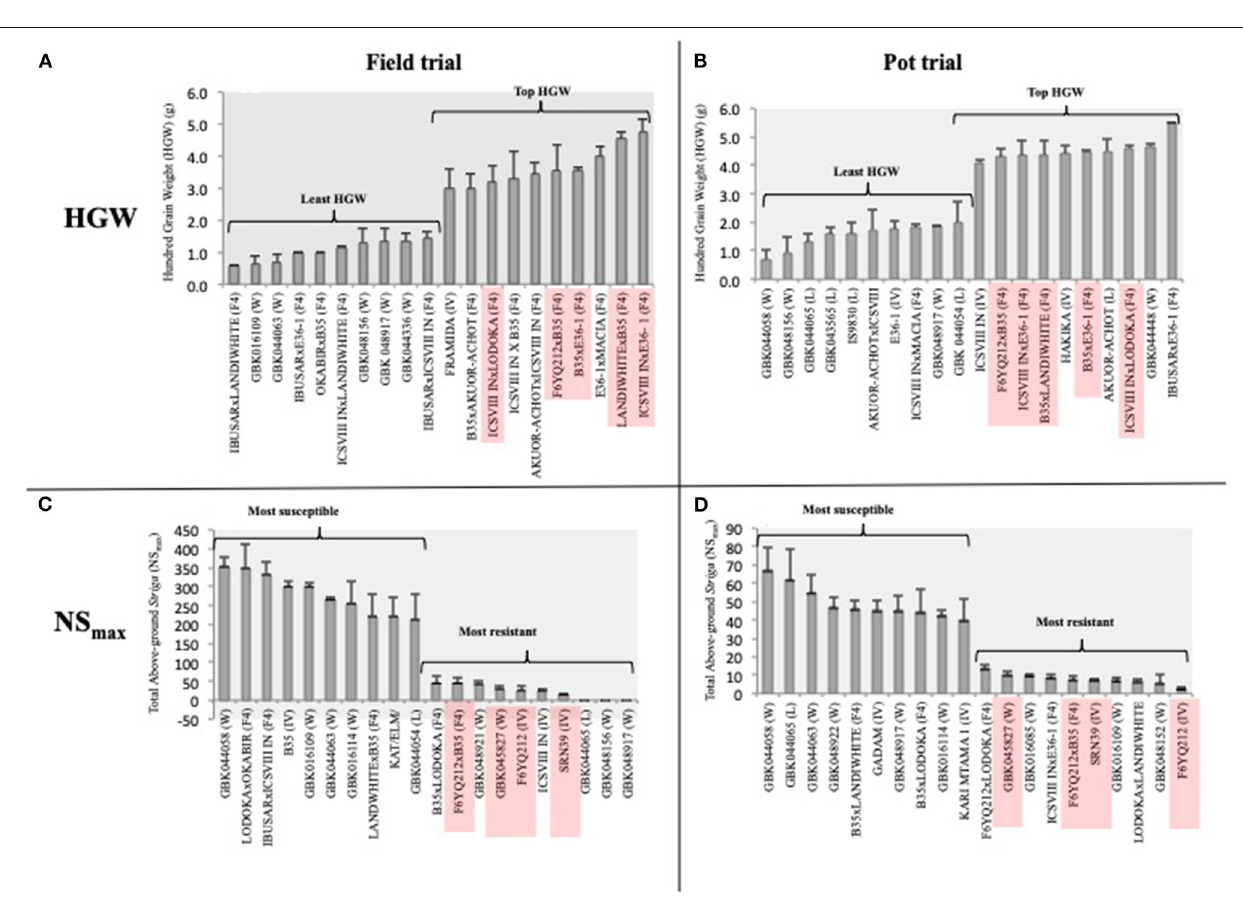
FIGURE 4 | The top 10 best and worst performers for HGW and Striga (NS max ) in the field (A,C) and pot trial (B,D) , respectively. Genotypes with consistent performance across the two environments are highlighted in